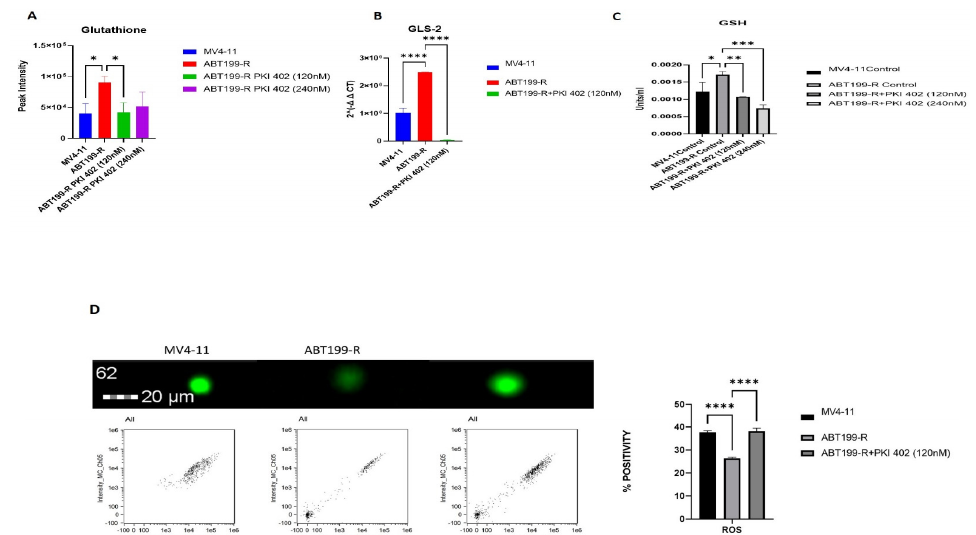
Figure 8. Redox homeostasis of venetoclax-resistant cells. ( A ) Glutathione (metabolite) involved in GSH pathway. ( B ) GLS-2 (gene) is involved in GSH pathway expression (RT-PCR). ( C ) Relative glutathione concentrations were measured using GSH assay from total protein. ( D ) ROS levels using CellRox Green Flow Cytometry assay. The channel Ch05 scans for red, and Ch02 scans for green. * p < 0.05, ** p < 0.01, *** p < 0.001, and **** p < 0.0001.